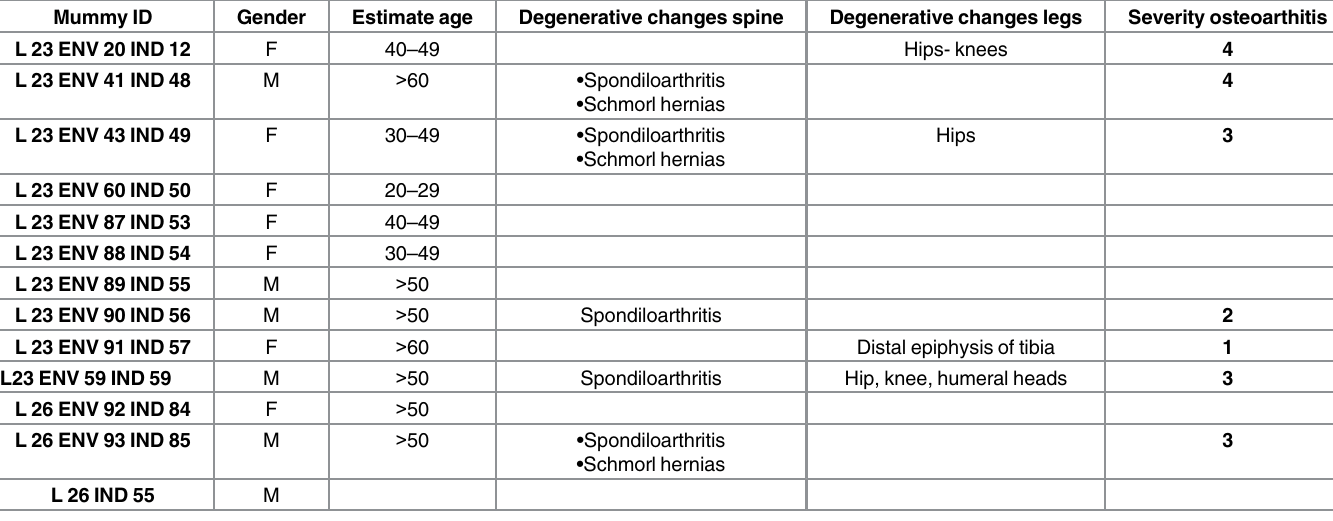
Table 3. Cases of chronic degenerative changes of the spine and of legs.